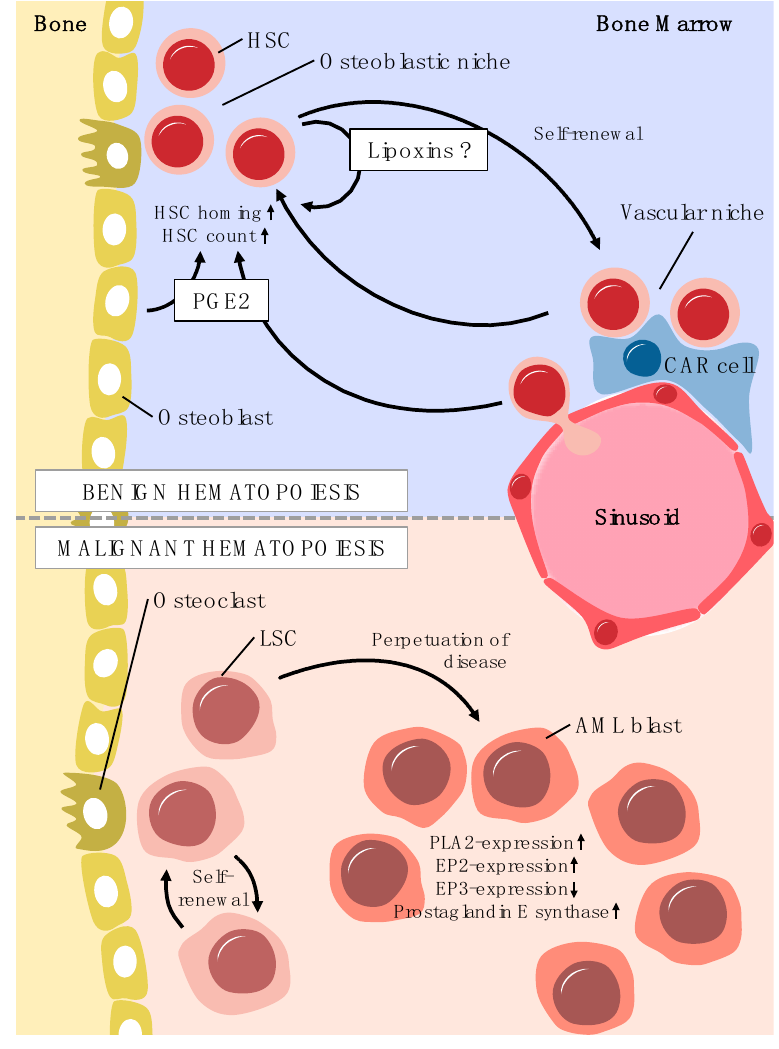
Figure 3. Lipid mediators in benign and malignant hematopoiesis. In benign hematopoiesis, PGE2 is secreted in large amounts in the osetoblastic niche and increases stem cell homing, and long-term LSC numbers. The role of lipoxins is still not fully understood, however lipoxins are required for stem cell quiescence and long-term renewal. In AML, LSC are considered to be chemoresistant and responsible for disease relapse. Self-renewal and maintenance of LSC in the bone marrow niche are increasingly better understood and growing data show alterations of lipid pathway enzymes suggesting eicosanoid pathways are active in leukemic blasts. HSC: hematopoietic stem cell, LSC: Leukemic stem cell; CAR cell: CXCL12-abundant reticular cell; PGE2: Prostaglandin E2; EP2: Prostaglandin E receptor 2; EP3: Prostaglandin E receptor 3; PLA2: Phospholipase A2.